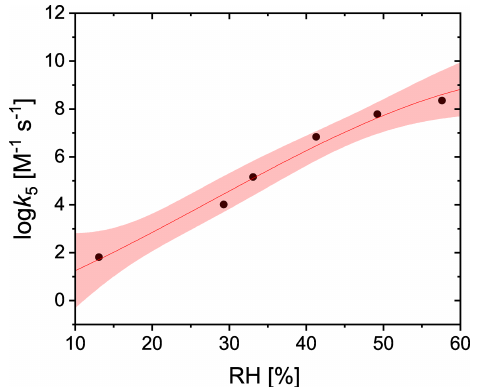
Figure A2. Adjusted values of the HO . self-reaction rate used in 2 for CWFT the PRAD model to exactly reproduce measured P HO . 2 experiments are shown as black dots. The red line and shading is the new parameterization (Eq. A11) and confidence intervals at 95% for the HO . self-reaction rate as a function of 2